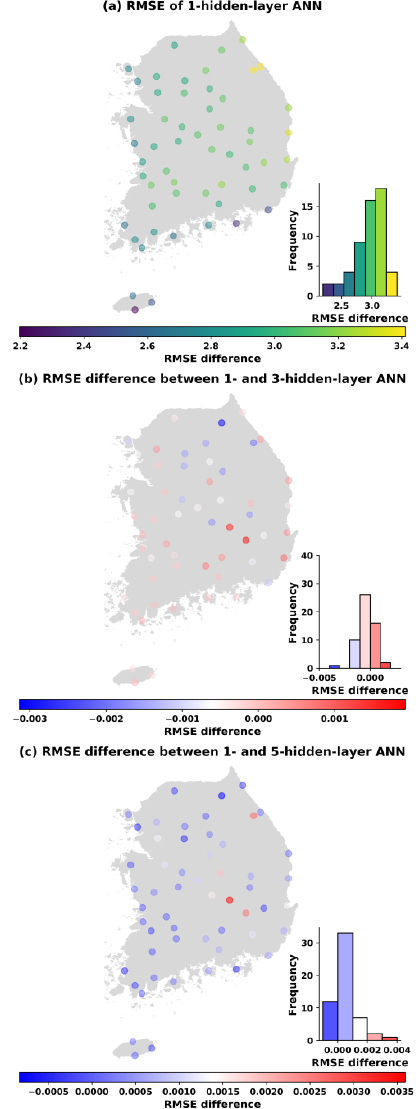
Figure 6. Panel ( a ) shows the RMSE of the test data of the 1-hidden layer model with 49 parameters; panel ( b ) shows the difference of the RMSE between the 1-hidden layer and the 3-hidden layer model (RMSE difference <0 indicates that the 1-hidden layer model performs better than the 3-hidden layer model and vice versa); and panel ( c ) shows the RMSE difference between the 1-hidden layer and the 5-hidden layer model (RMSE difference <0 indicates the that the 1-hidden layer model performs better, RMSE difference >0 shows the opposite).